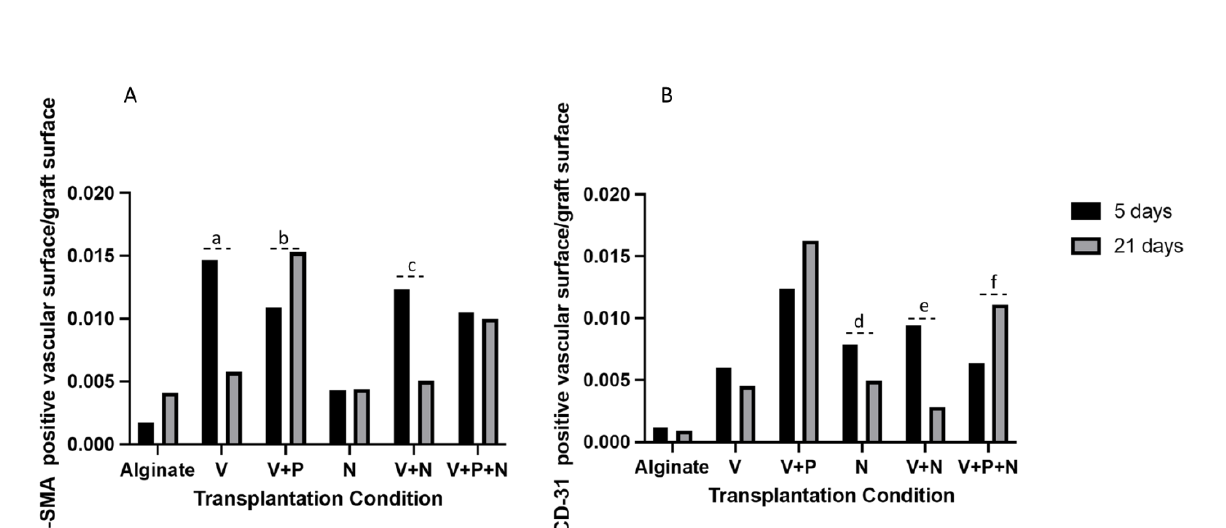
Figure 6. Impact of NP supplementation on the blood vessels’ evolution between 5 and 21 days in mice testicular tissue auto-transplants. ( A ) α-SMA- and ( B ) CD31-positive surfaces in the grafts were compared after 5 and 21 days of transplantation. a: p = 0.03; b: p = 0.04; c: p < 0.01; d: p = 0.01; e: p = 0.02; f: p = 0.03. n = 3. The ratio between the CD-31/α-SMA-positive vascular surface, representing the pro-